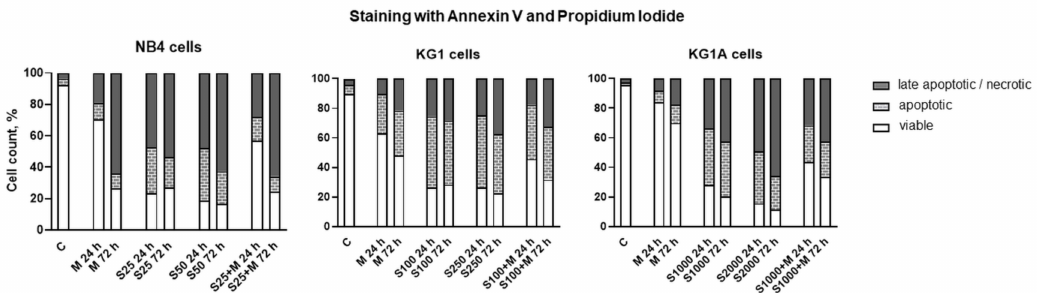
Figure 5. Metformin and MCL-1 inhibitor S63845 effect on cell apoptosis. Cell apoptosis of NB4 cells (treated with 25 nM and 50 nM S63845, 10 mM metformin and combination of 25 nM S63845 + 10 mM metformin), KG1 cells (treated with 100 nM and 250 nM S63845, 10 mM metformin and combination of 100 nM S63845 + 10 mM metformin), as well as KG1A cells (treated with 1000 nM and 2000 nM S63845, 10 mM metformin and combination of 1000 nM S63845 + 10 mM metformin) was evaluated by staining with Annexin V and Propidium Iodide after 24 and 72 h of treatment. Results are mean ( n = 3; S.D. < ± 10%). Note: statistical analysis was performed using 2-way ANOVA with Tukey’s multiple comparison test (due to the complexity of data, exact statistical analysis results are presented in Appendix No. 2, (Supplementary